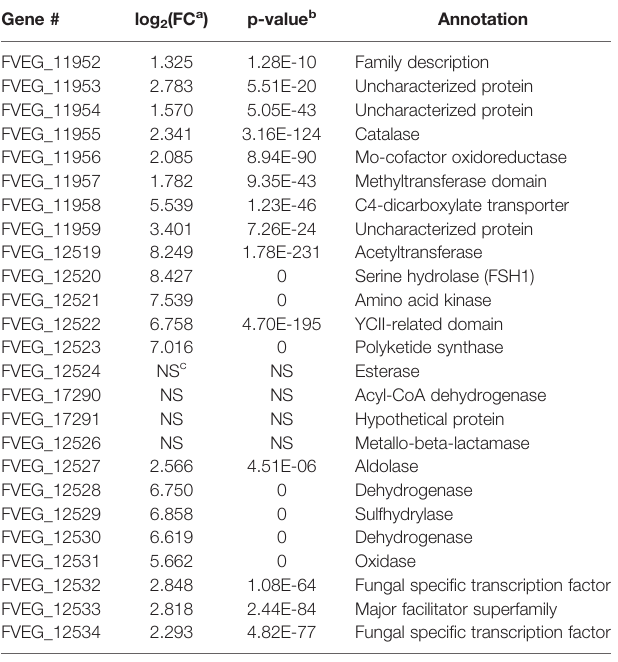
TABLE 3 | Gene clusters with differential expression upon exposure to 2-coumaranone (CMN). Gene # log 2 (FC a )